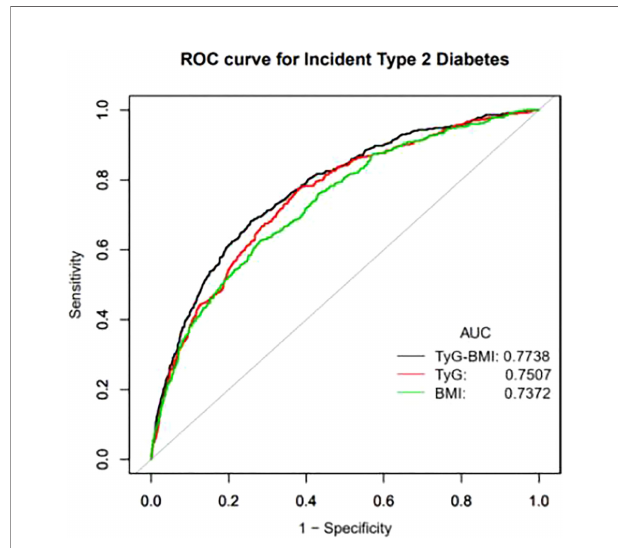
FIGURE 2 | Receiver operating characteristic (ROC) curve analyses to predict incident T2DM. AUC, area under the curve; TyG-BMI, triglyceride glucose-body mass index; TyG, triglyceride-glucose; BMI, body mass index.